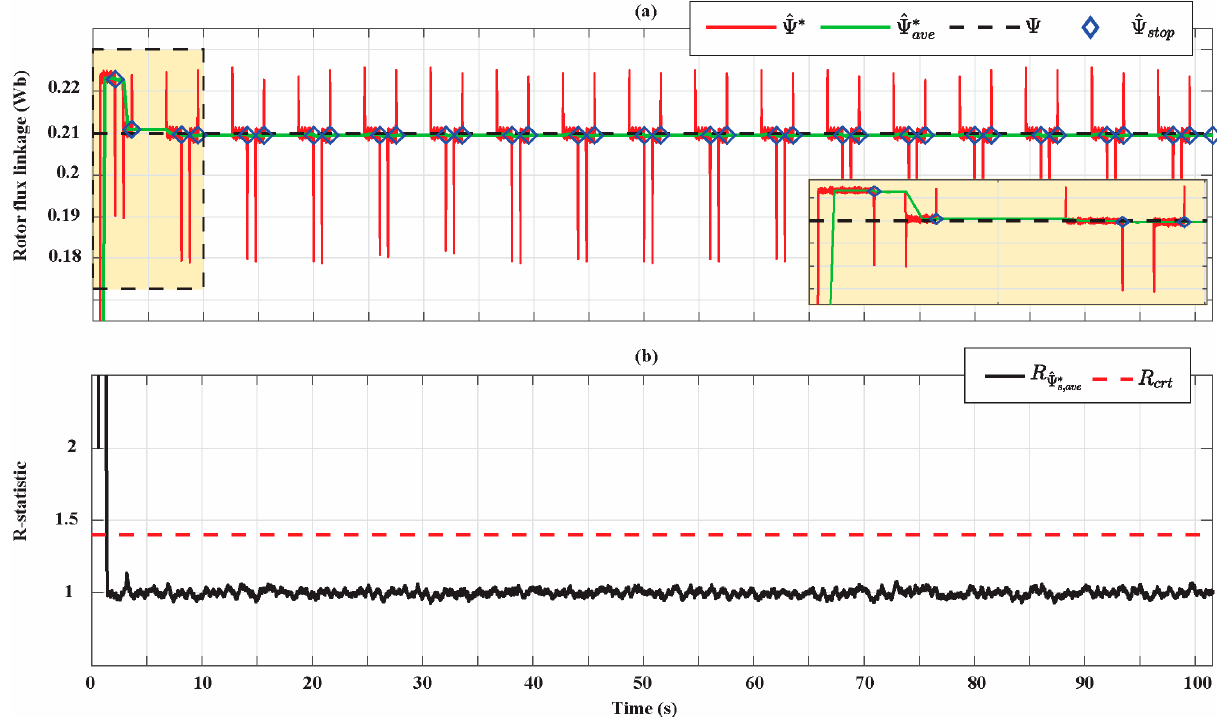
Figure 10. ( a ) Rotor flux linkage estimation for the Bonfiglioli 65; ( b ) R-statistic analysis of the rotor flux linkage estimation.